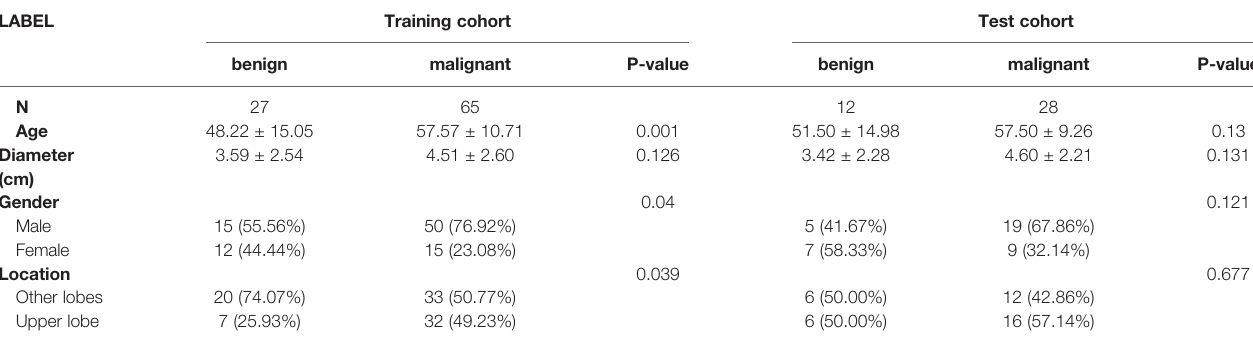
TABLE 1 | Clinical features of training and test cohorts.